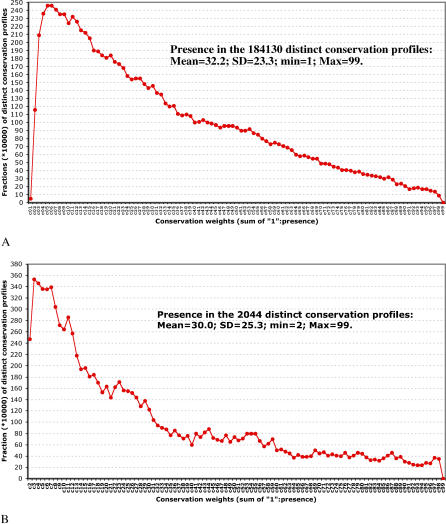
Distinct Conservation Profiles and Corresponding Weights(A) Distribution of the whole set of distinct conservation profiles (184,130) according to the 99 possible weight classes varying from one to 99.(B) Similar distribution restricted to the subset of distinct conservation profiles (2,044) associated with proteins from at least two species.